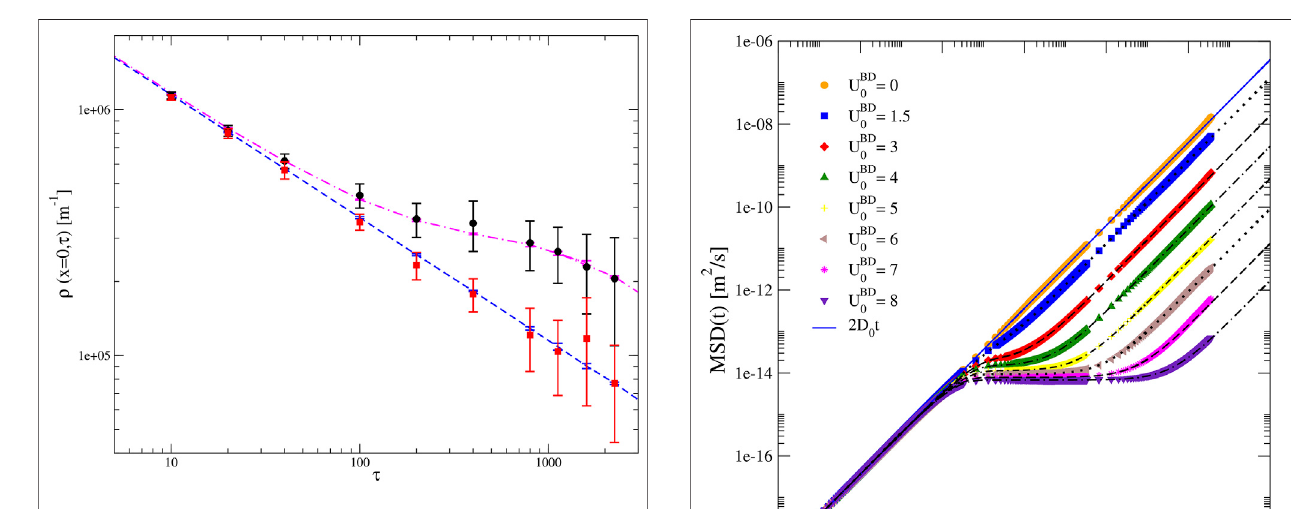
FIGURE 5 | (Color online): Maximum of the density of probability of fi nding a tracer ρ ( x , τ ) at x (cid:2) 0 as a function of the reduced time τ (cid:2) t / Δ t , with Δ t (cid:2) ( 1 / 30 ) s . The solid squares and the dashed line correspond to experimental and Brownian dynamics results, respectively, in the absence of an external fi eld. The black solid circles and the magenta dot- dashed line correspond to experimental and Brownian dynamics results, respectively, in the presence of a periodic cosine-like external fi eld. FIGURE 6 | (Color online): Mean square displacement MSD(t) of a